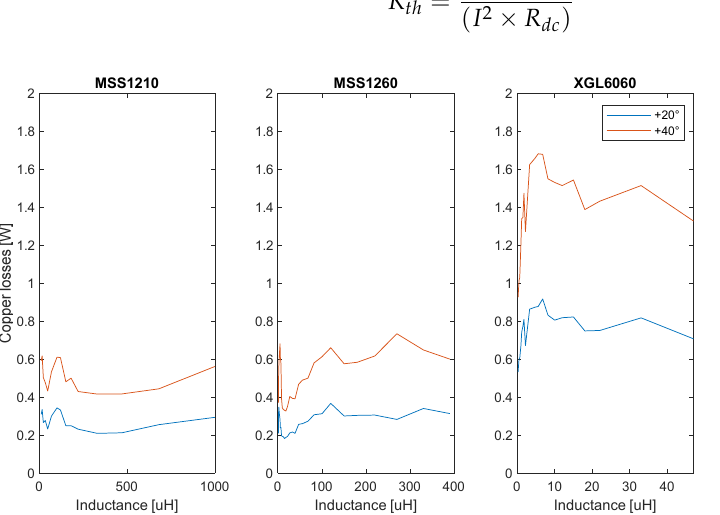
Figure 24. Maximum losses allowed in the inductor for various inductor values and for two tempera- ture rises. Data extracted from datasheets [15–17]. Table 5. Median thermal resistance of copper to the core in MSS1210, MSS1260 and XGL6060 series. Series MSS1210 MSS1260 MSS6060 Median of the thermal resistance R th ( ◦ C/W) 75 79 26 at +20 ◦ Median of the thermal resistance R th ( ◦ C/W) 80 83 at +40 ◦